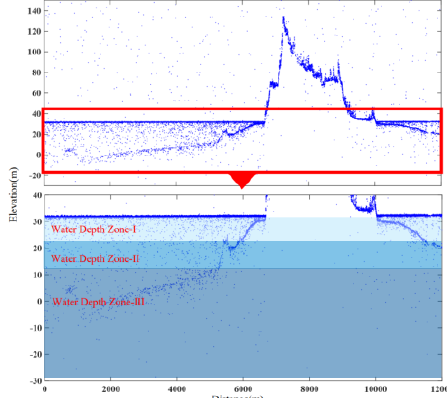
Figure 6. Diagram of the water depth zone division. As the water depth increases, the photon SNR becomes lower.